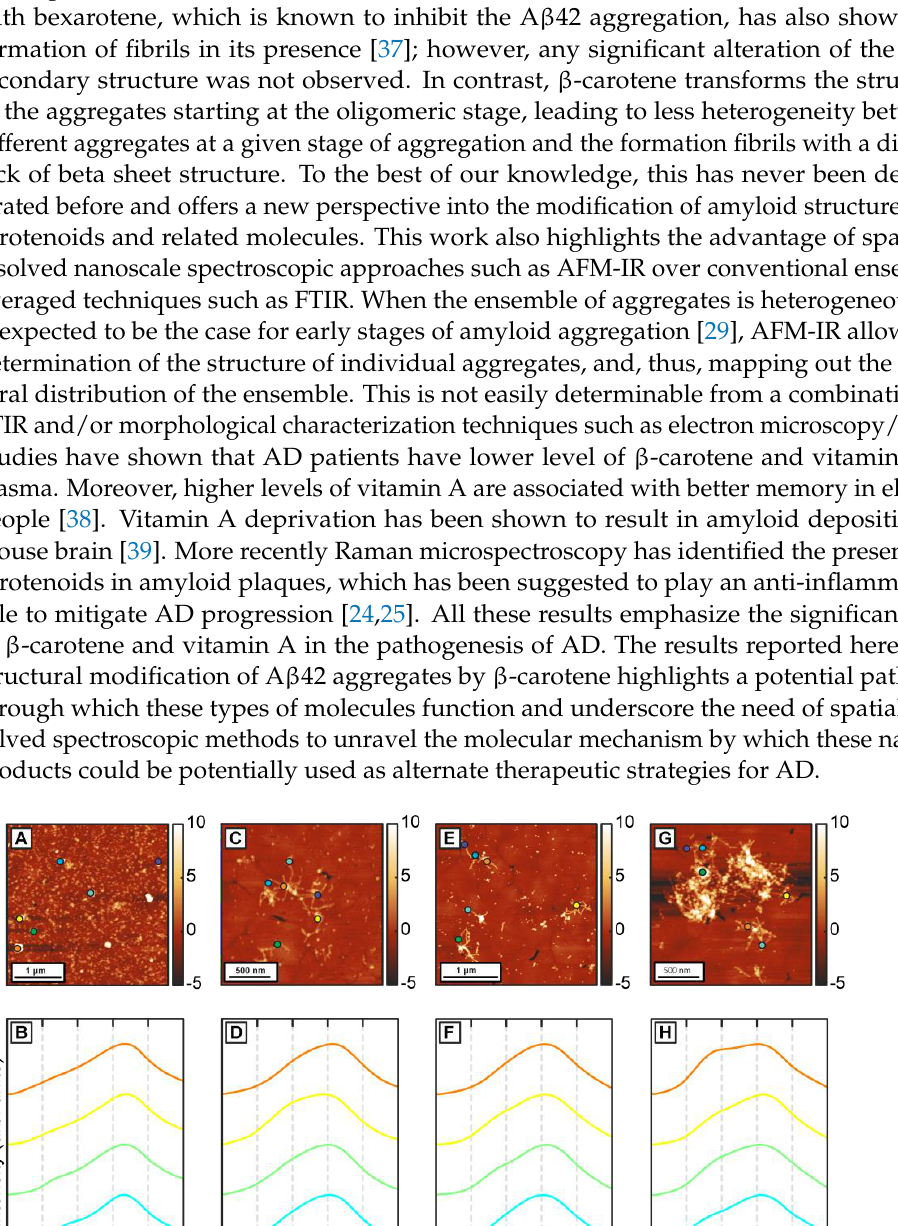
Figure 5. Ratio of intensity of amide I band at 1666 cm −1 to that at 1636 cm −1 at different time-points during aggregation. Higher value of ratio indicates relative increase in non-beta sheet/disordered structure. The data point for ordered polymorph at 1 h is missing, since no such aggregates were found. The ratios were calculated for each of the spectra shown in Figures 1 – 4, and mean values are shown here. Error bars denote the standard deviation. The present study highlights the structural effects that can be induced by β -carotene on Aβ42 aggregates starting from the oligomeric stage. While previous measurements have identified that β - carotene modulates Aβ aggregation, the precise effect it has on the structure of the aggregates is difficult to discern without structural resolution at the single aggregate level. Earlier studies have shown similar results with Aβ40, where thioflavin T (ThT) assays indicated a slowing down of the aggregation kinetics in both 1:1 and 1:2 ratio aggregation mixture, instead of complete inhibition. It has also been demonstrated that